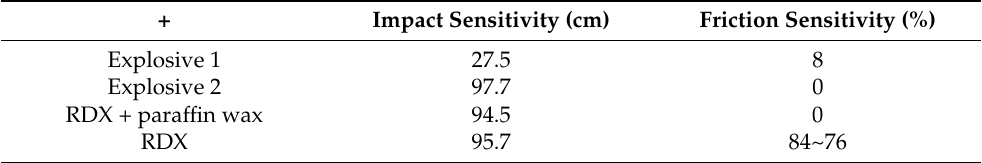
Table 9. Impact and friction sensitivity of the two explosive samples.